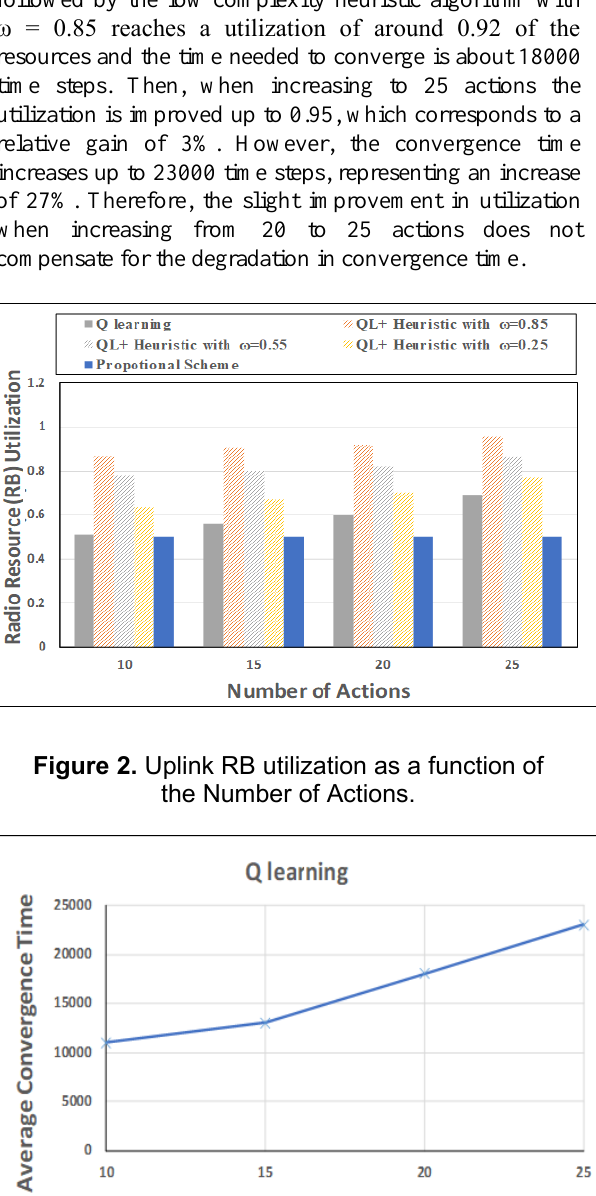
Fig.4 plots the obtained RB utilization for UL, as a